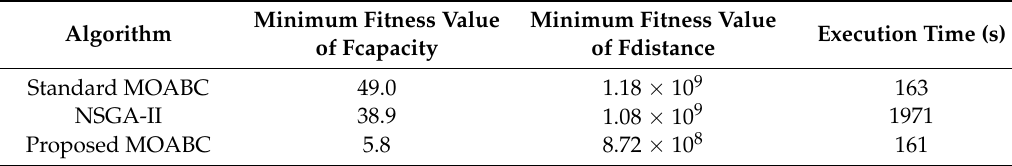
Table 3. The comparison results of three algorithms.